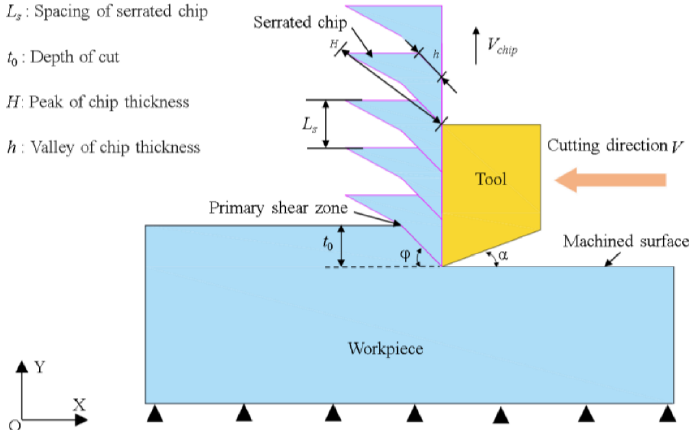
Figure 10. Schematic diagram of the serrated chip formation